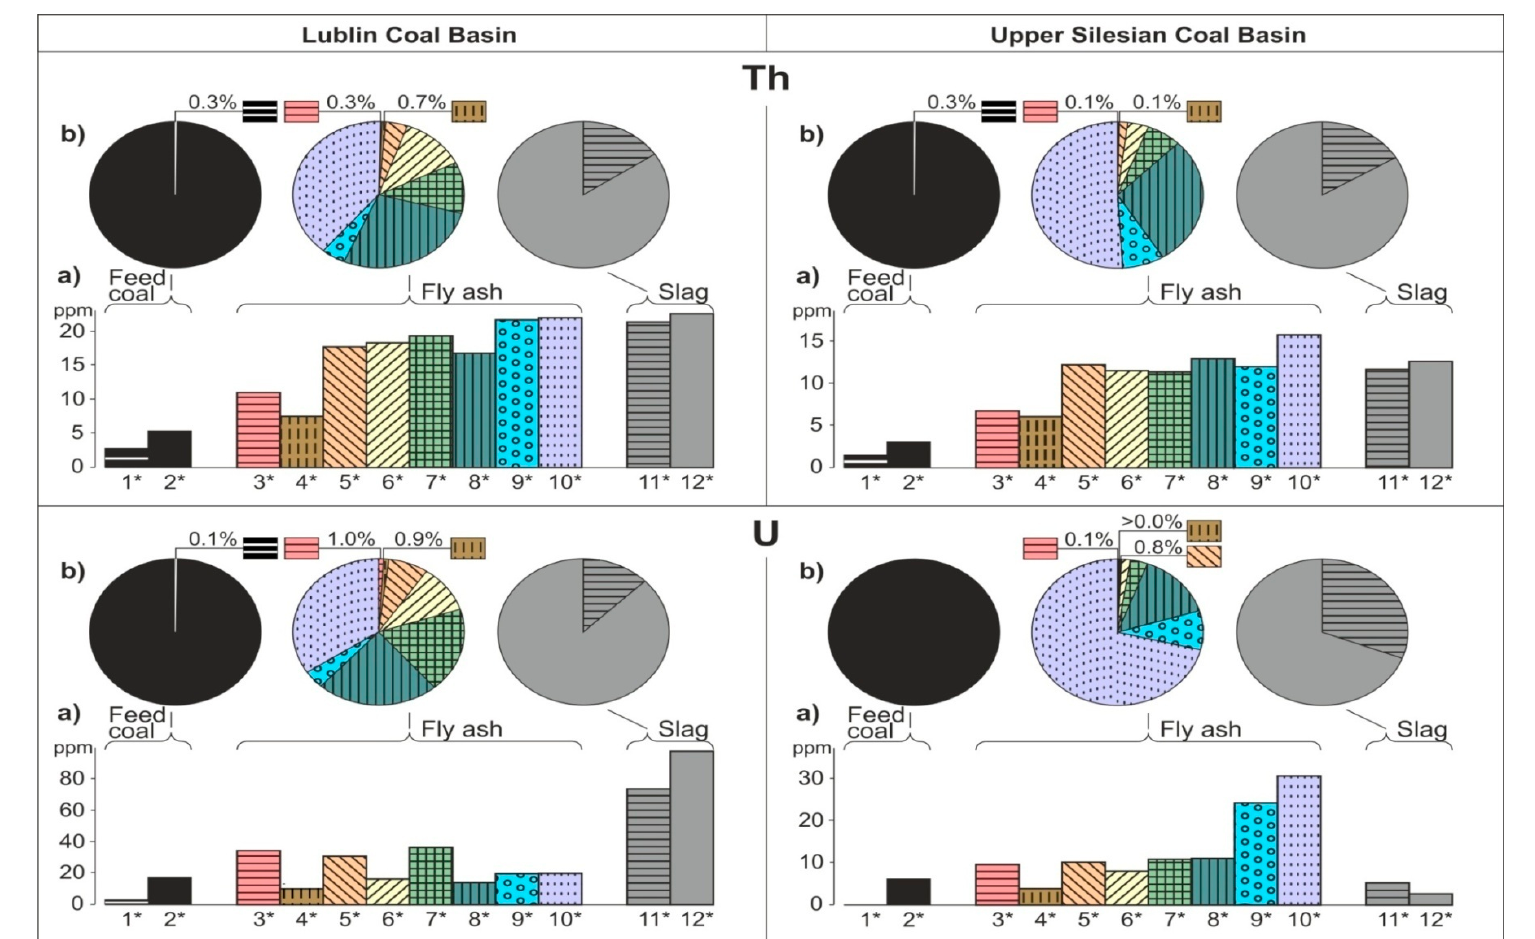
Figure 3. The distribution of U and Th content in the feed coal from the Lublin (LCB) and Upper Silesian Coal Basin (USCB) and in the fly ash and slag, ( a ) and their proportions in determining the average element concentration in fly ash and slag ( b ) (Table S6). *1—magnetic and 2—nonmagnetic fraction of the feed coal, 3–10 fly ash: (3—magnetic and 4—nonmagnetic fraction >0.5 mm, 5—magnetic and 6—nonmagnetic fraction 0.5–0.2 mm, 7—magnetic and 8—nonmagnetic fraction 0.2–0.05 mm, 9—magnetic and 10—nonmagnetic fraction <0.05 mm), 11—magnetic and 12—nonmagnetic fraction of the slag.